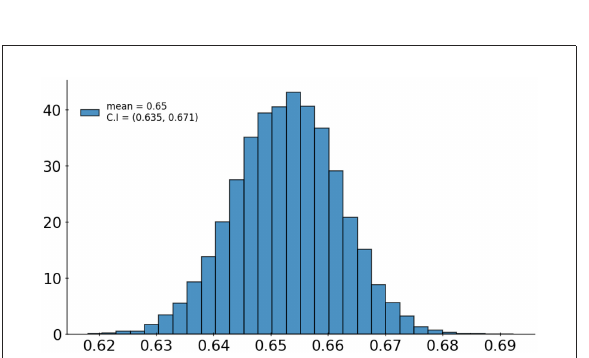
FIGURE6 Bootstrap distribution of F1 scores of the VinDr-CXR abnormality classifier over 10,000 samples drawn from 6,285